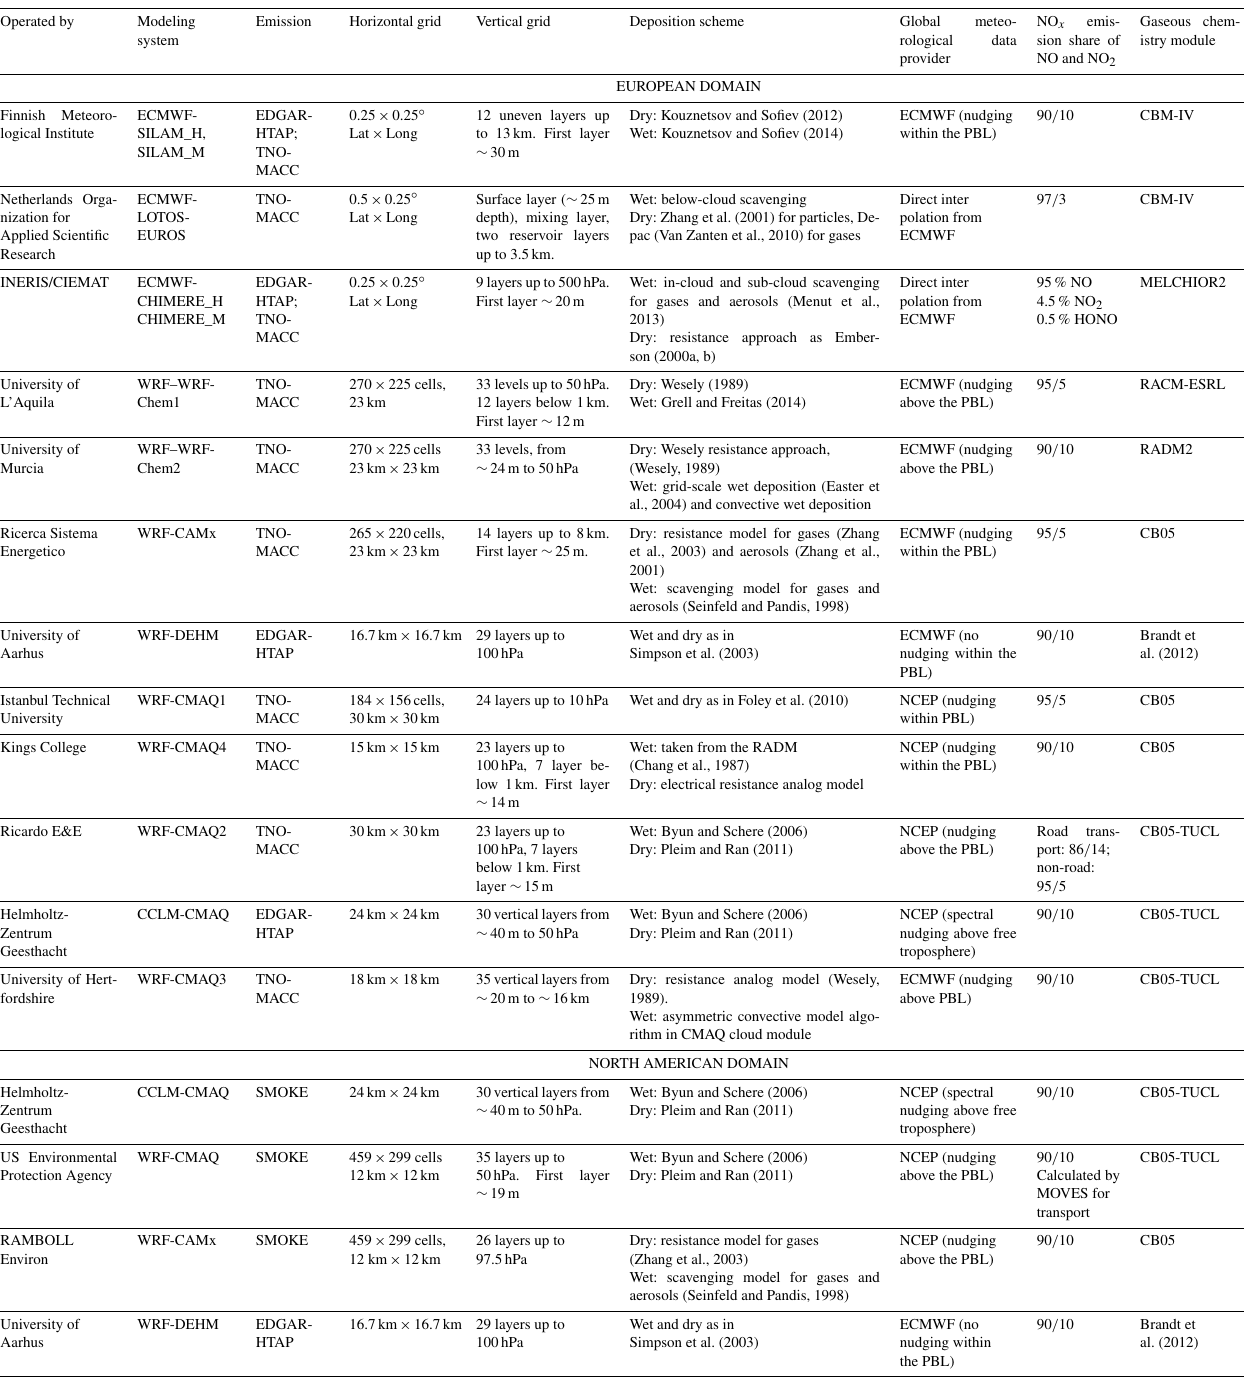
Table 1. Participating Modelling systems and key